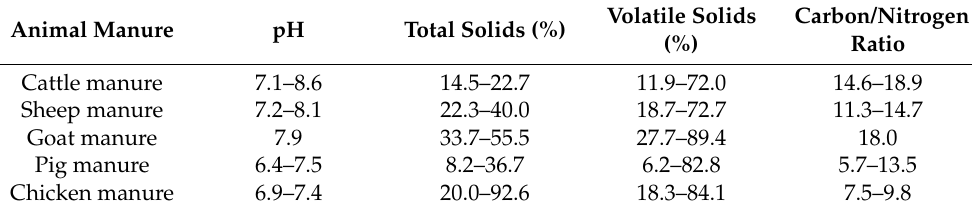
Table 3. Physicochemical characteristics of different animal manure